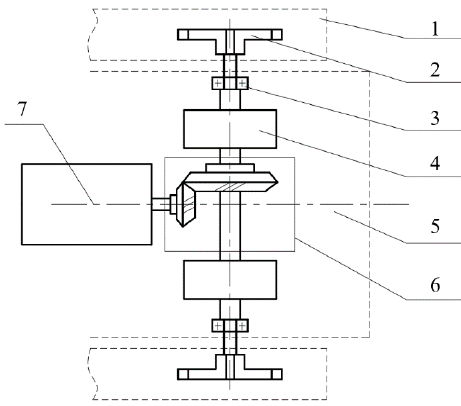
Figure 6. Driving, transmission, and steering mechanism (1—track, 2—driving wheel, 3—pillow block, 4—electromagnetic particle clutch, 5—baseboard, 6—bevel gear reducer, 7—motor).